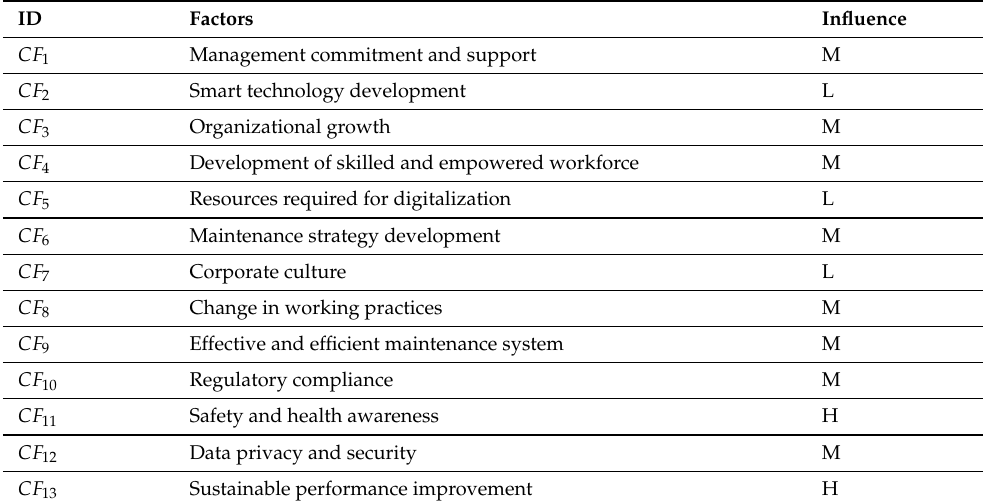
Table 3. Critical factors of maintenance management published in Ref.